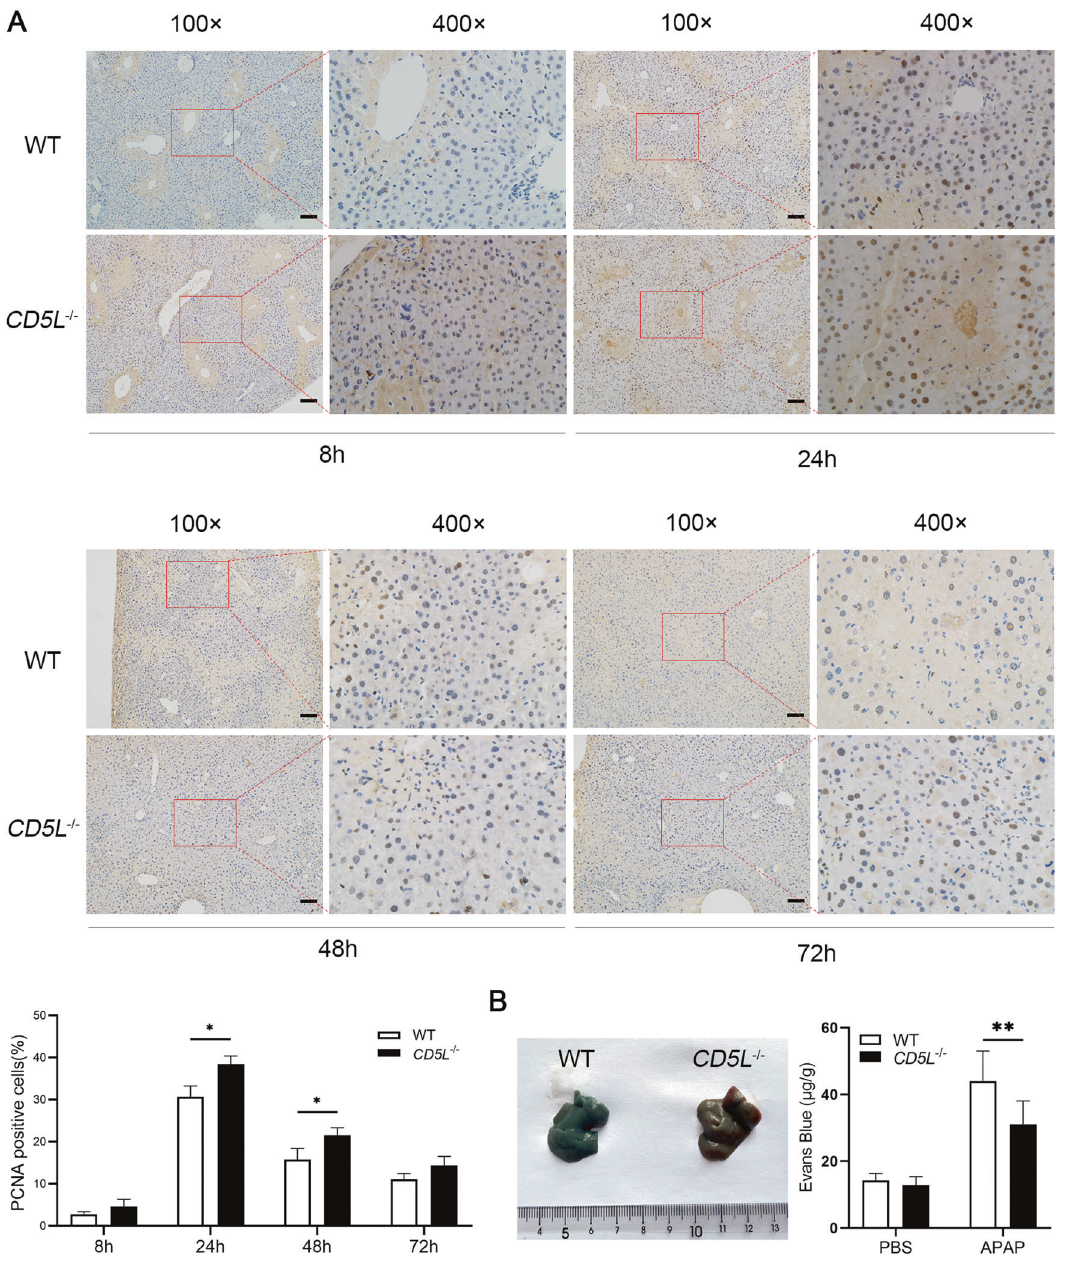
Fig. 6 The proliferation of hepatocytes is increased in CD5L − / − mice. A Immunohistochemical staining of PCNA in WT and CD5L − / − mouse liver at the indicated time point after PBS or APAP treatment ( n = 5 for each group at each time point). Deeply stained nucleus indicates positive results. The ratio of PCNA positive cells to total hepatocytes was calculated. Representative images are shown. Scale: 100 μ m. B Vascular endothelial permeability after APAP treatment for 24 h was determined by Evans Blue assay ( n = 8 for each group). The results are presented as means ± SD of at least three independent experiments. * P < .05; ** P <